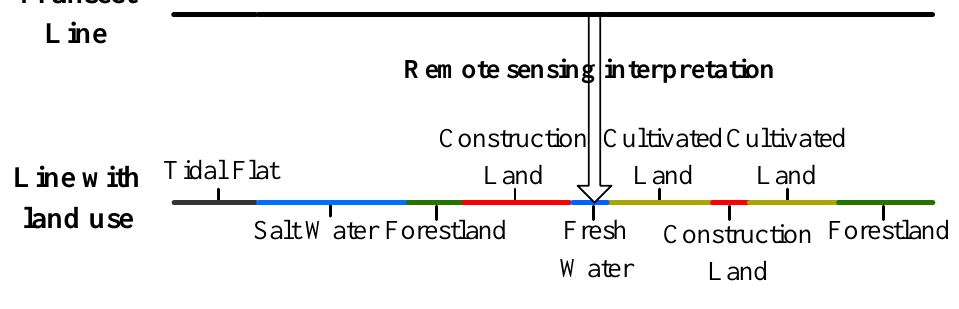
Figure 2. The coastal transect line land use.